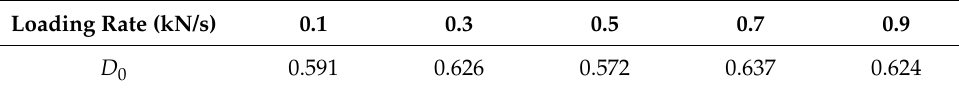
Table 1. Initial damage D 0 under different loading rates. Loading Rate